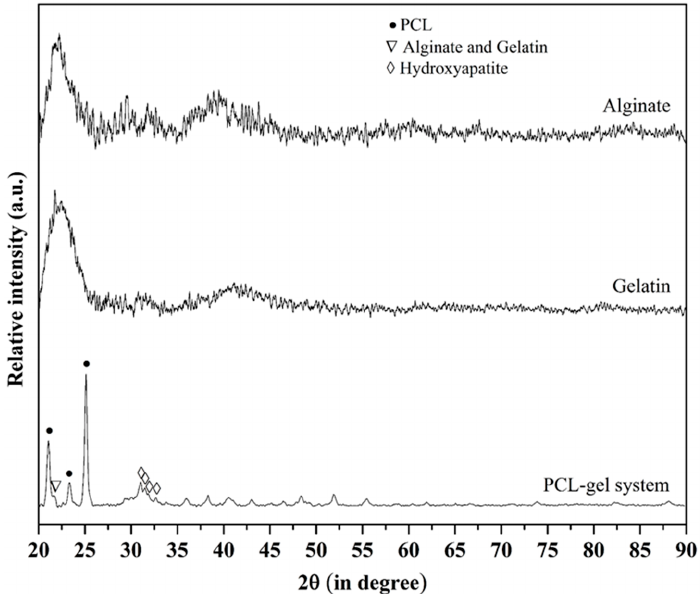
Figure 3. A comparison of X-ray diffraction (XRD) data of hybrid PCL/hydrogel scaffolds with alginate, and gelatin confirmed the presence of semi-crystalline phases of alginate and gelatin in the hydrogel loaded in the PCL scaffold ( ∇ ). The diffraction data also confirmed the presence of PCL ( • ) and hydroxyapatite (HA) ( ♦ ) in its monolithic